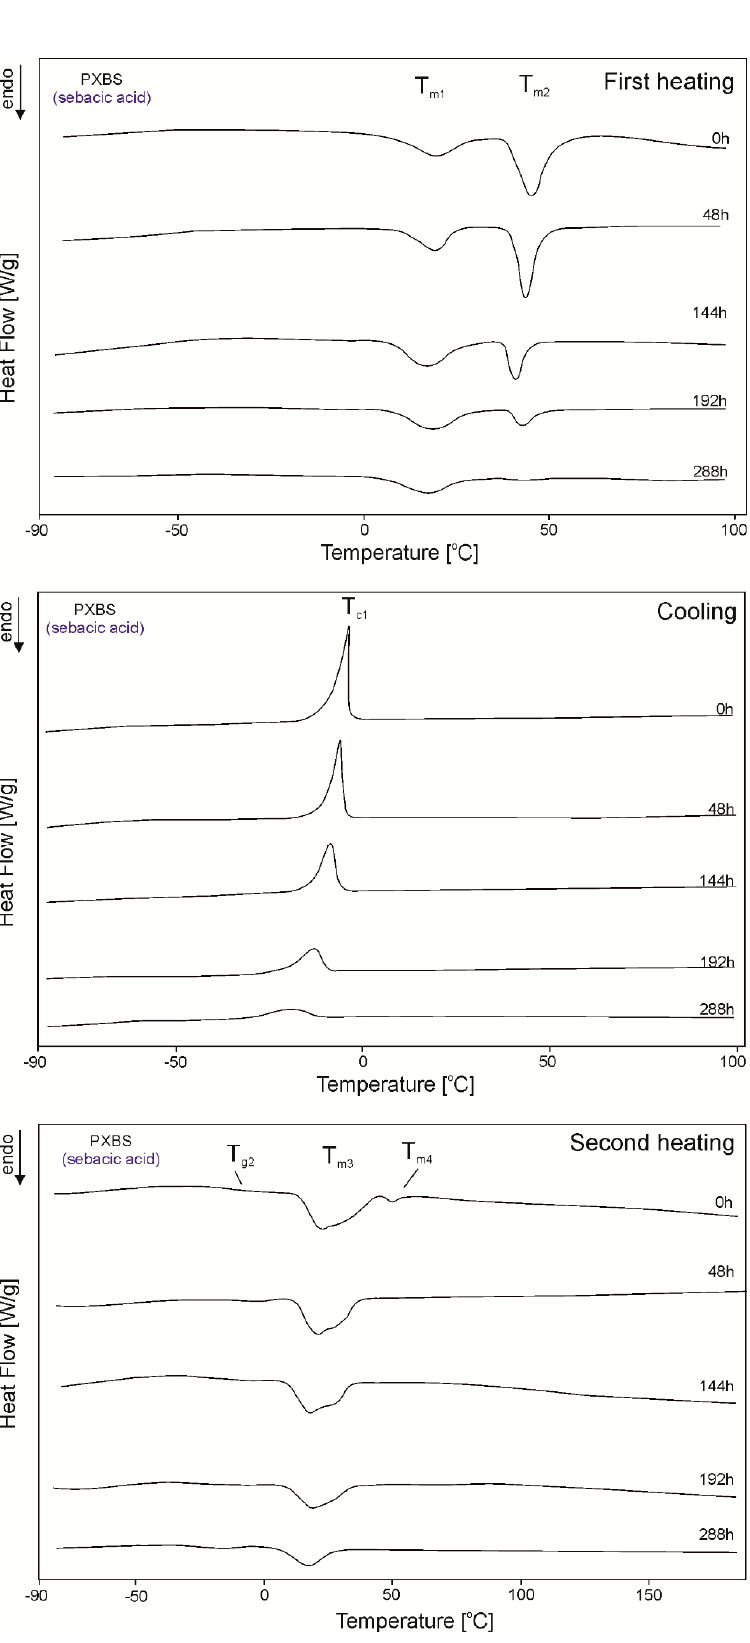
Figure 8. DSC thermograms of PXBS at the crosslinking stages subjected to first heating, second heating and